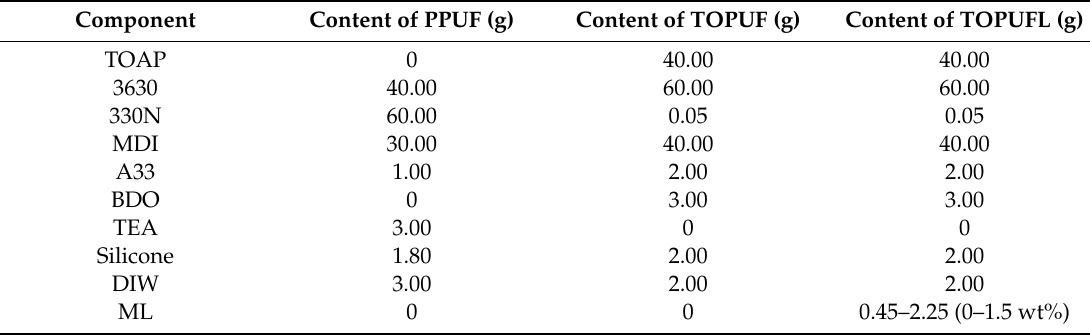
Table 2. Foam formulation and